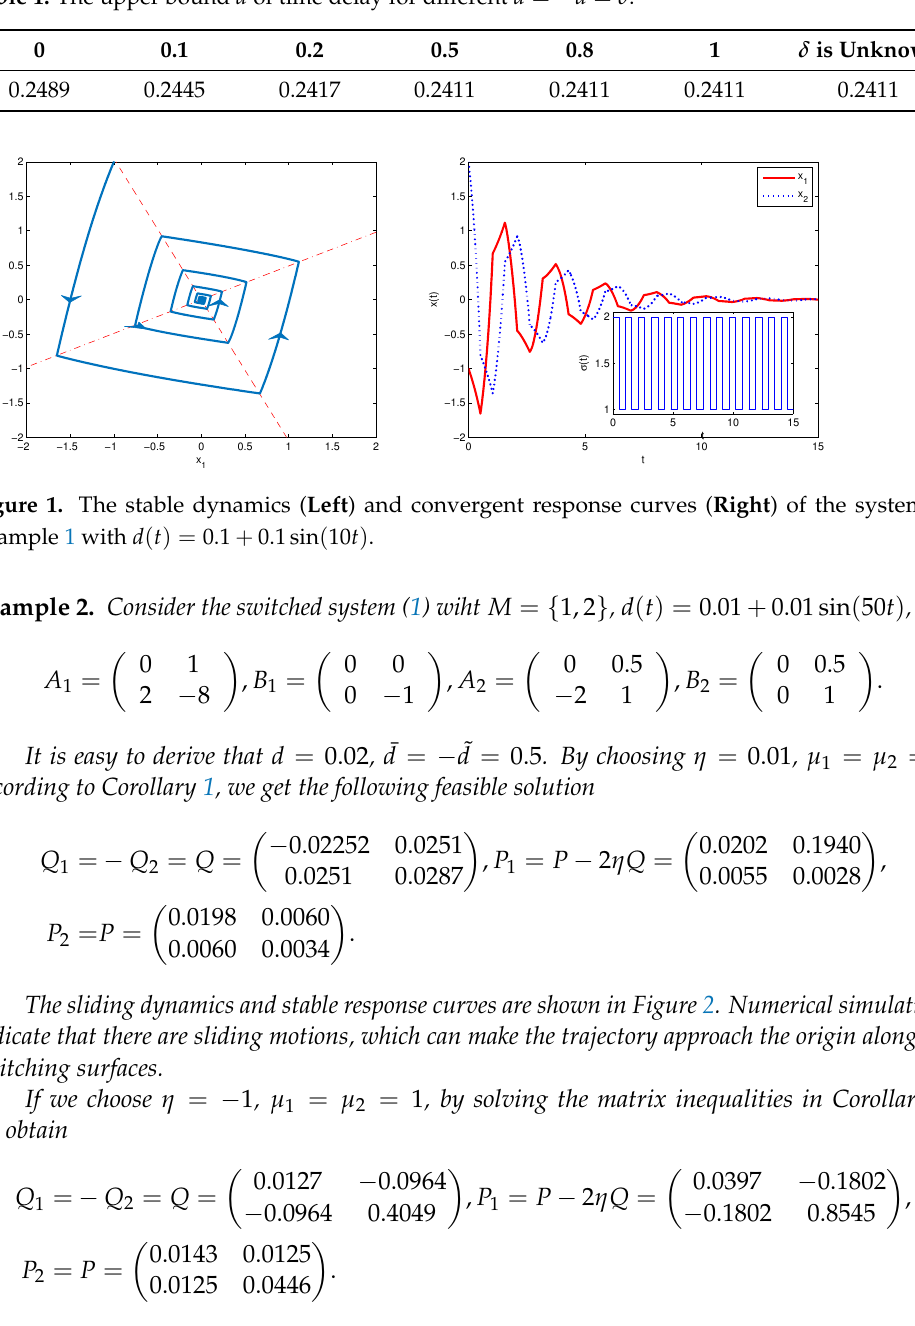
Table 1. The upper bound d of time delay for different ¯ d = − ˜ d = δ .